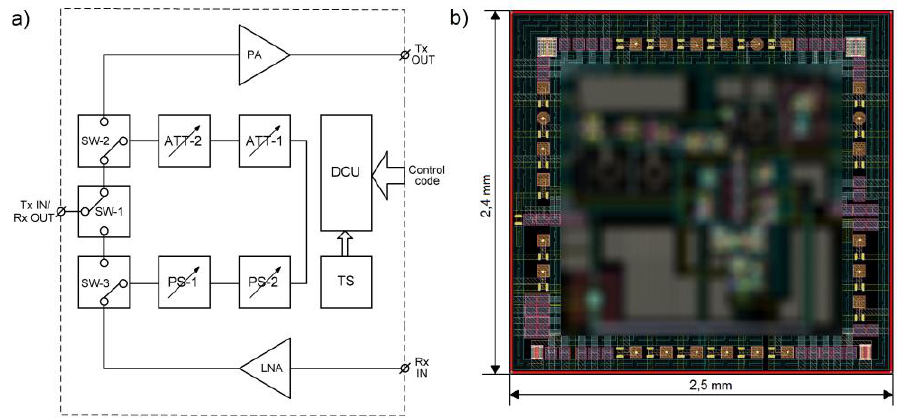
Fig. 2. Block diagram (a) and layout (b) of the designed Core